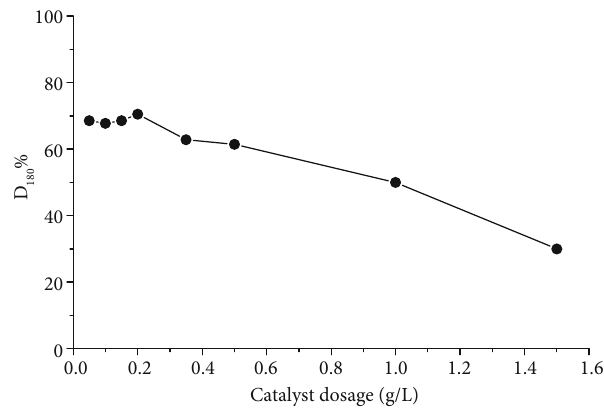
Figure 14: E ff ect of initial concentration of (RB5) Fe Þ = 0 : 2 g/L as